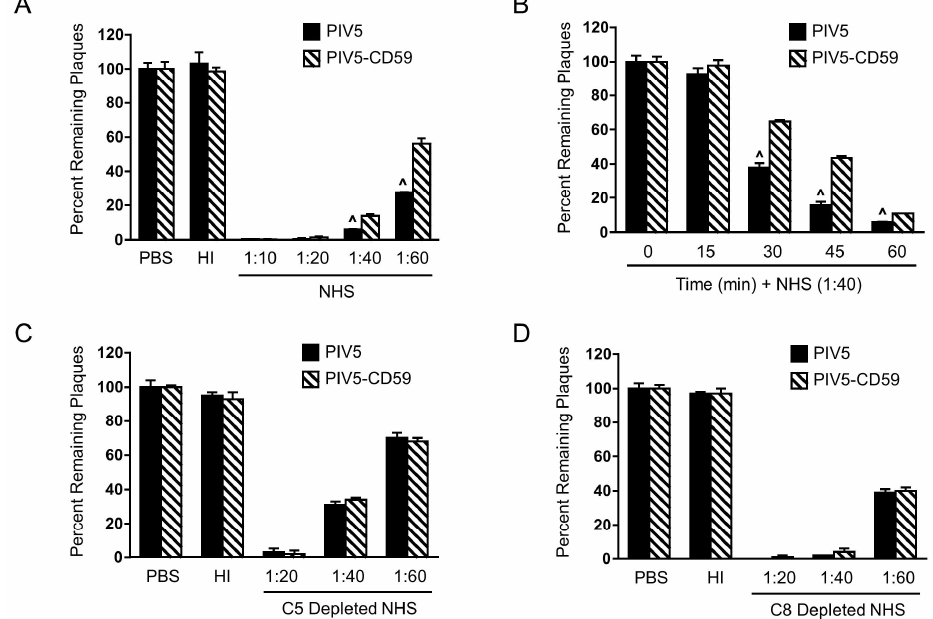
Figure 5. Effect of NHS on neutralization of CD59-associated PIV5. One hundred PFU of PIV5 derived from control CHO cells (PIV5) or CHO-59 cells (PIV5-CD59) was incubated with the indicated dilutions of NHS for 1 h ( A ) or with NHS at a dilution of 1:40 for the indicated times ( B ). The remaining infectivity was determined by using the plaque assay. ( C , D ) Serum depleted of C5 ( C ) or depleted of C8 ( D ) was tested as described for panel A for neutralizing PIV5 or PIV5-CD59. As a control, the virus was incubated with PBS alone for 1 h. Data are from three independent reactions and error bars represent standard deviation. ^ p < 0.01 when comparing PIV5 derived from CHO-CD59 cells to PIV5 derived from CHO control